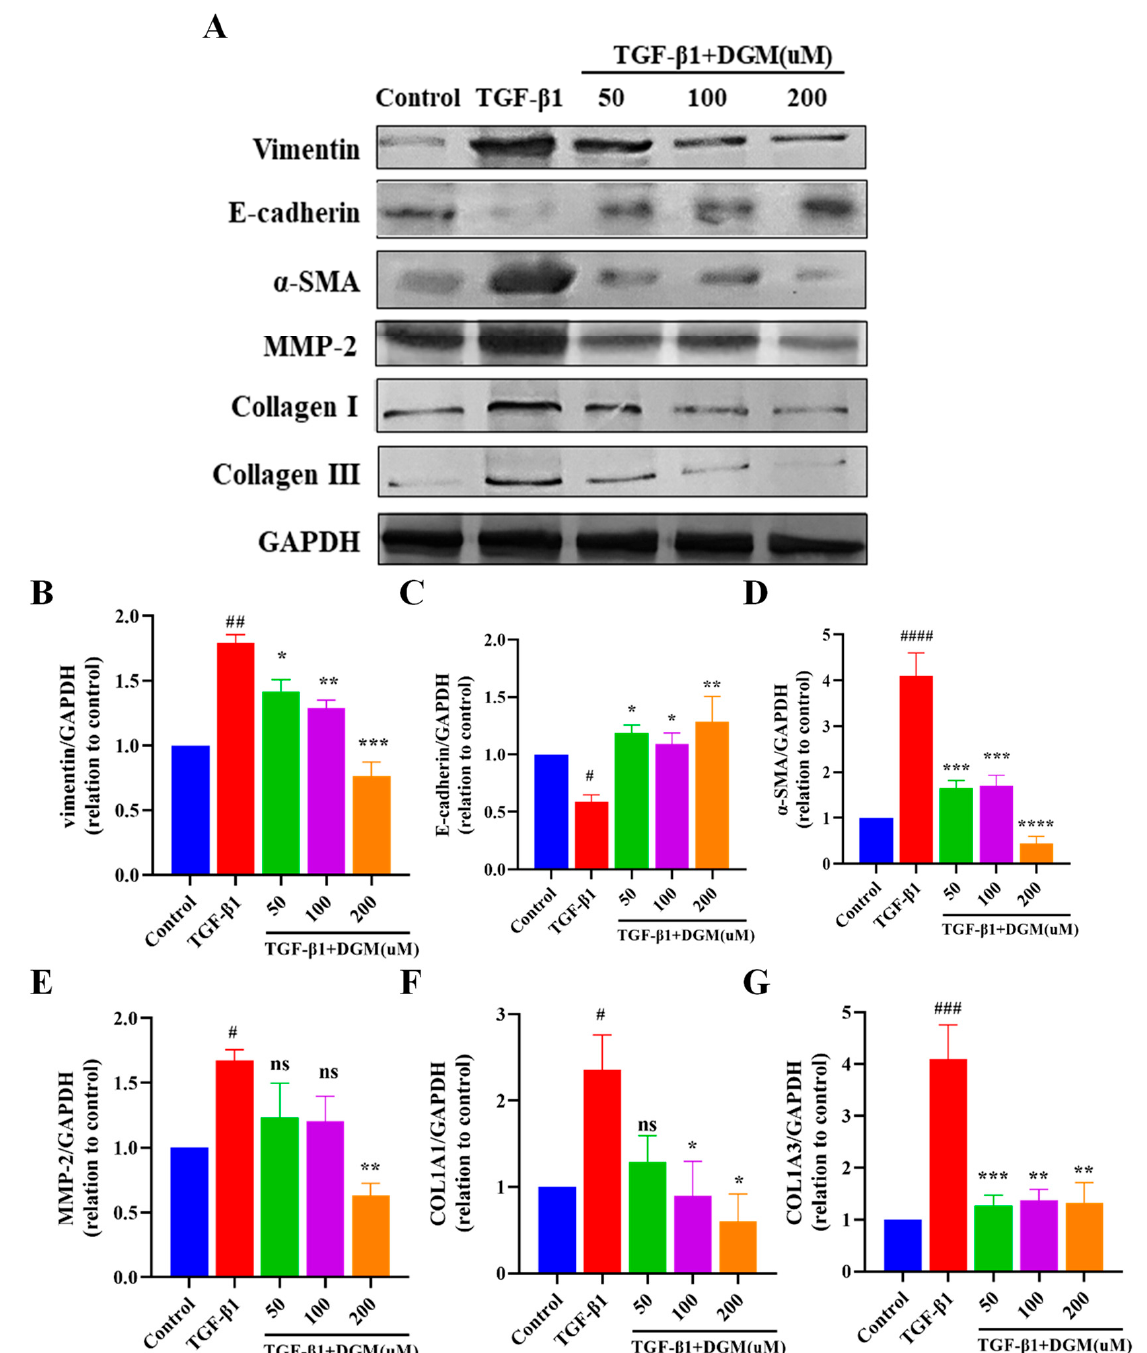
Figure 2. DGM alleviates the EMT process induced by TGF- β 1 in A549 cells. A549 cells were treated with TGF- β 1 in combination with different concentrations (50, 100, and 200 µ M) of DGM for 48 h, and intracellular proteins were extracted for subsequent Western blot analysis. ( A ) Protein expression levels of vimentin, E-cadherin, α -SMA, MMP-2, Collagen I, and Collagen III were evaluated by Western blotting. ( B ) Quantification of the vimentin/GAPDH ratio. ( C ) Quantification of the E- cadherin/GAPDH ratio. ( D ) Quantification of the α -SMA/GAPDH ratio. ( E ) Quantification of the MMP-2/GAPDH ratio. ( F ) Quantification of the Collagen I/GAPDH ratio. ( G ) Quantification of the Collagen III/GAPDH ratio. Data represent the mean ± SEM ( n = 3). # p < 0.05, ## p < 0.01, ### p < 0.001, #### p < 0.0001 vs. control group; * p < 0.05, ** p < 0.01, *** p < 0.001, **** p < 0.0001 vs. TGF- β 1 group.